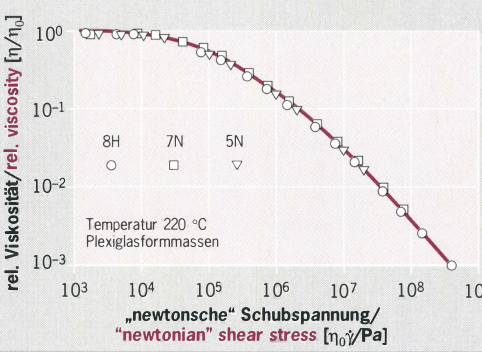
Fig. 2: Reference viscosity functions of Plexiglas melts BH, lN and 5N from reference